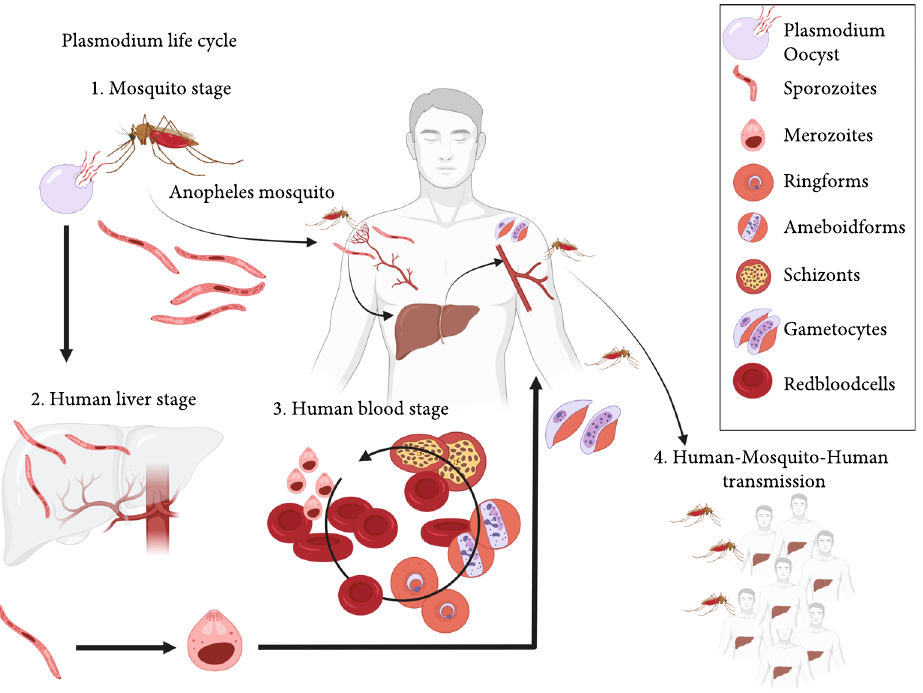
Figure 1: The host-pathogen-environment